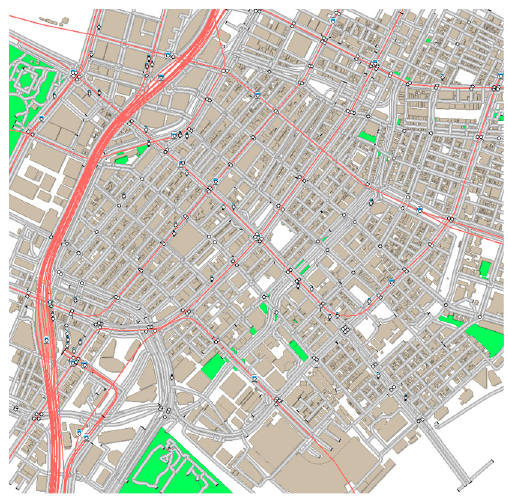
Figure 5. Simulation area (Ginza in Tokyo).